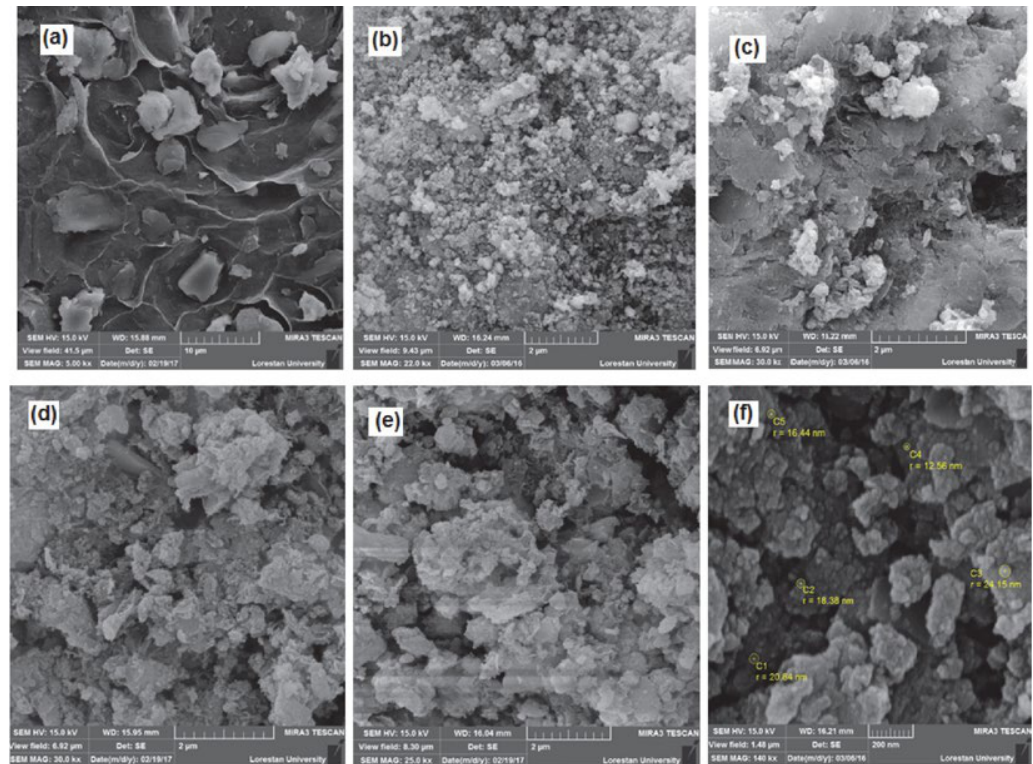
Figure 5. SEM images of (a) GO, (b) Fe